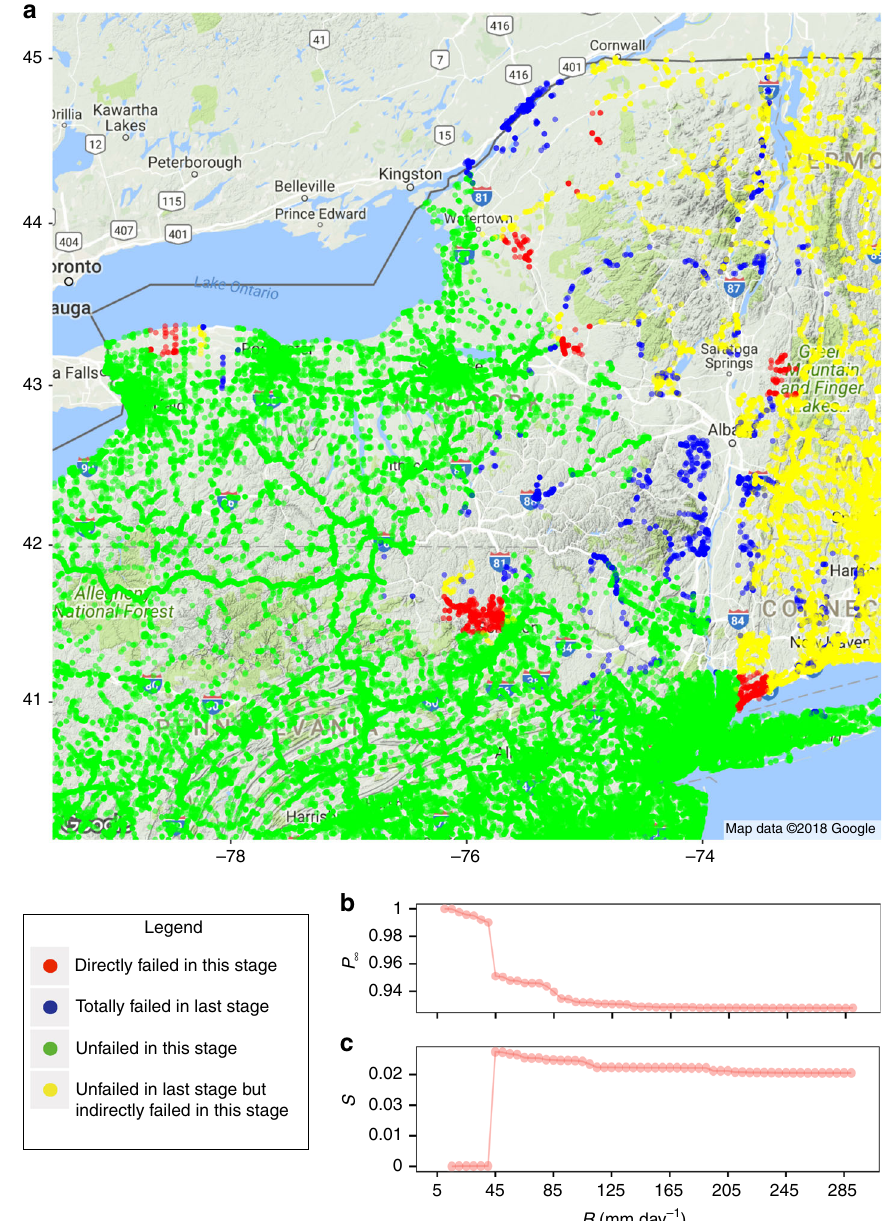
Fig. 4 Percolation in New York. a Geographical layout of road intersections disturbed by fl ooding in New York under normal fl ooding scenarios when the input surface runoff ( R ) increases 40 mm (last stage) to 45 mm (this stage) per day. b Fraction of nodes in the giant connected component ( P ∞ ) of a road network in the US as a function of the runoff only in New York. c Fraction of nodes in the second largest connected component ( S ) on a road network of China as a function of the runoff only in New